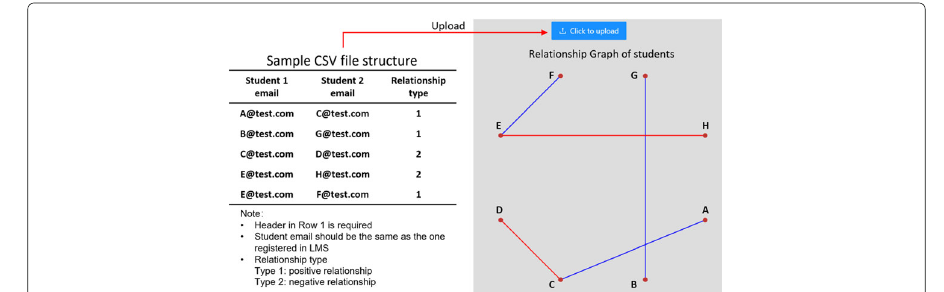
Fig. 4 Creating and visualizing friendMship for group formation